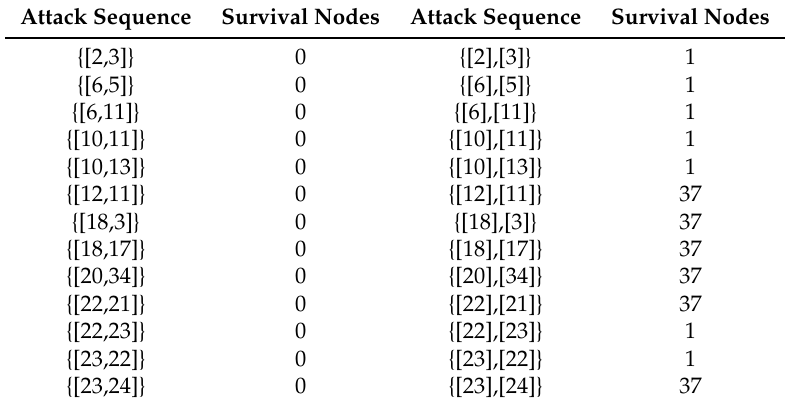
Table 1. Target sets with whom a simultaneous attack would cause more damage.